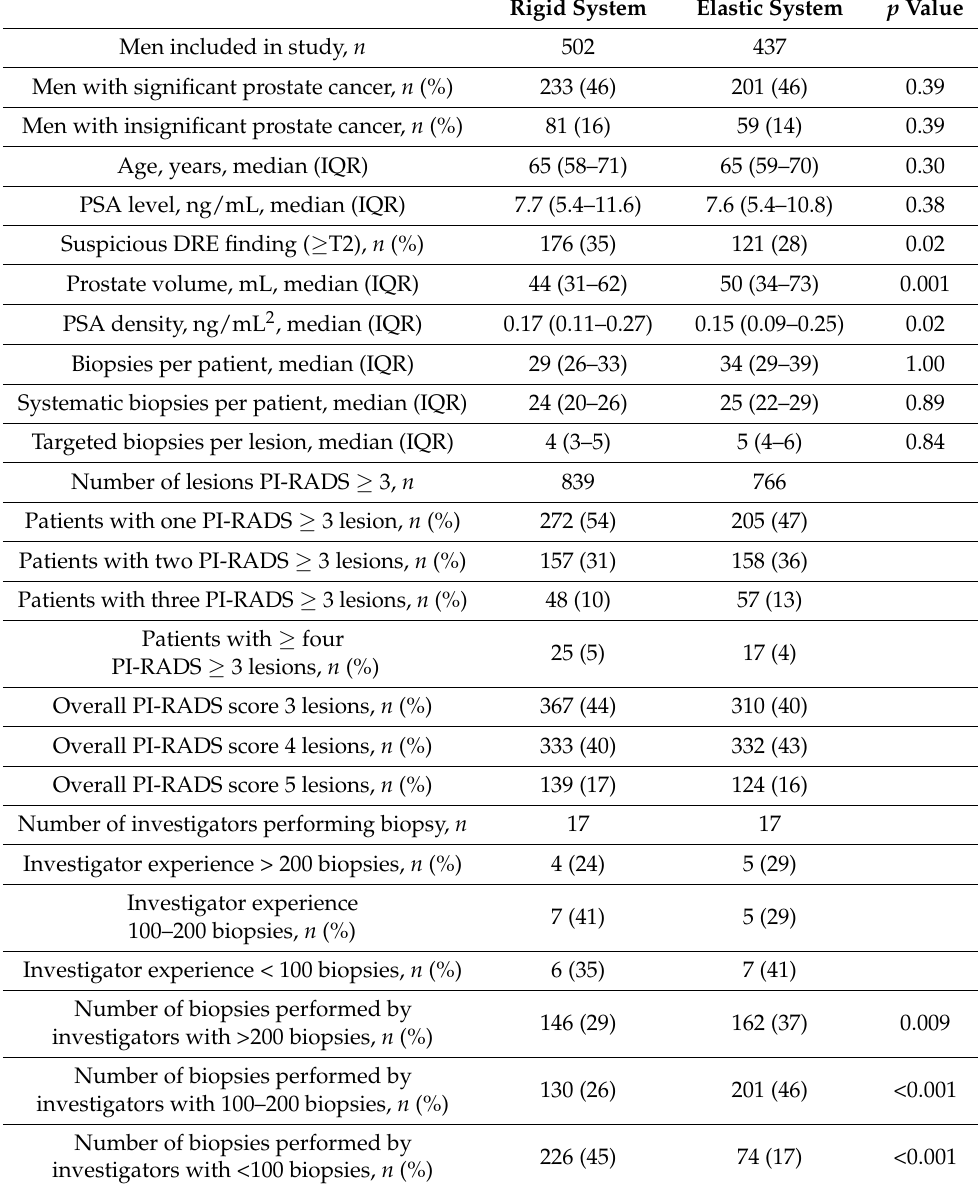
Table 1. Patient characteristics, magnetic resonance imaging findings, and biopsy cores for the rigid and elastic registration patient groups according to START protocol [24]. DRE = digital rectal examination; IQR = inter-quartile range; PI-RADS = Prostate Imaging-Reporting and Data System; PSA = prostate specific